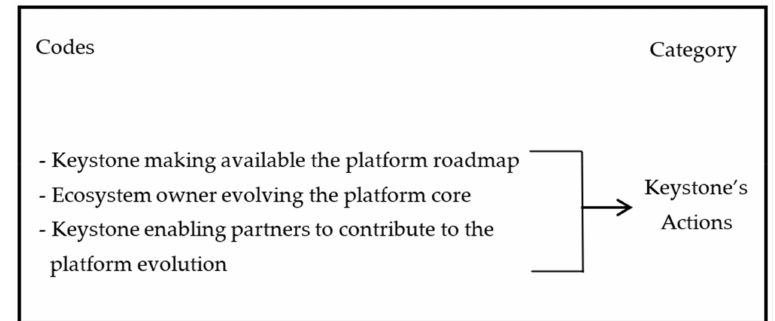
Figure 4. Open coding: creating